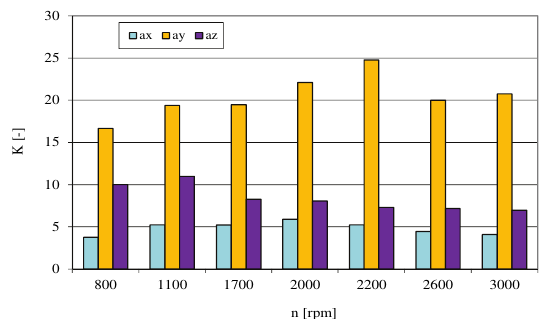
Fig. 7. Shape coefficient of vibration accelerations for X, Y and Z dimen- sions and different engine speeds